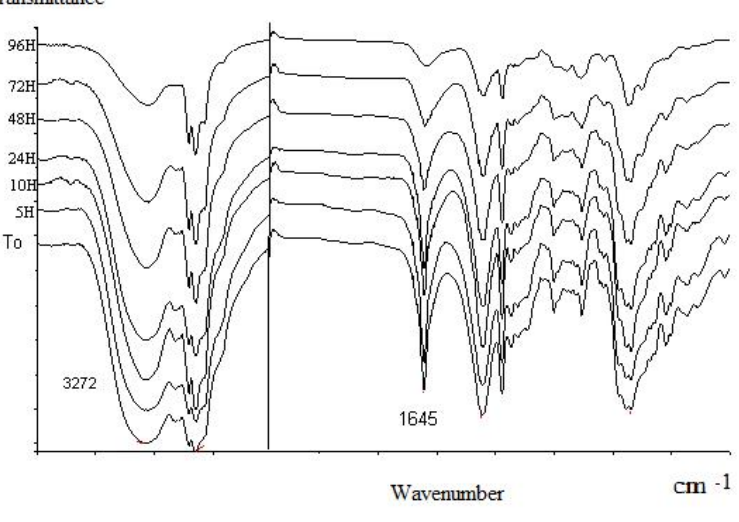
Figure 3. Infra-red spectra of OP from L. multiflora essential oil in different times.